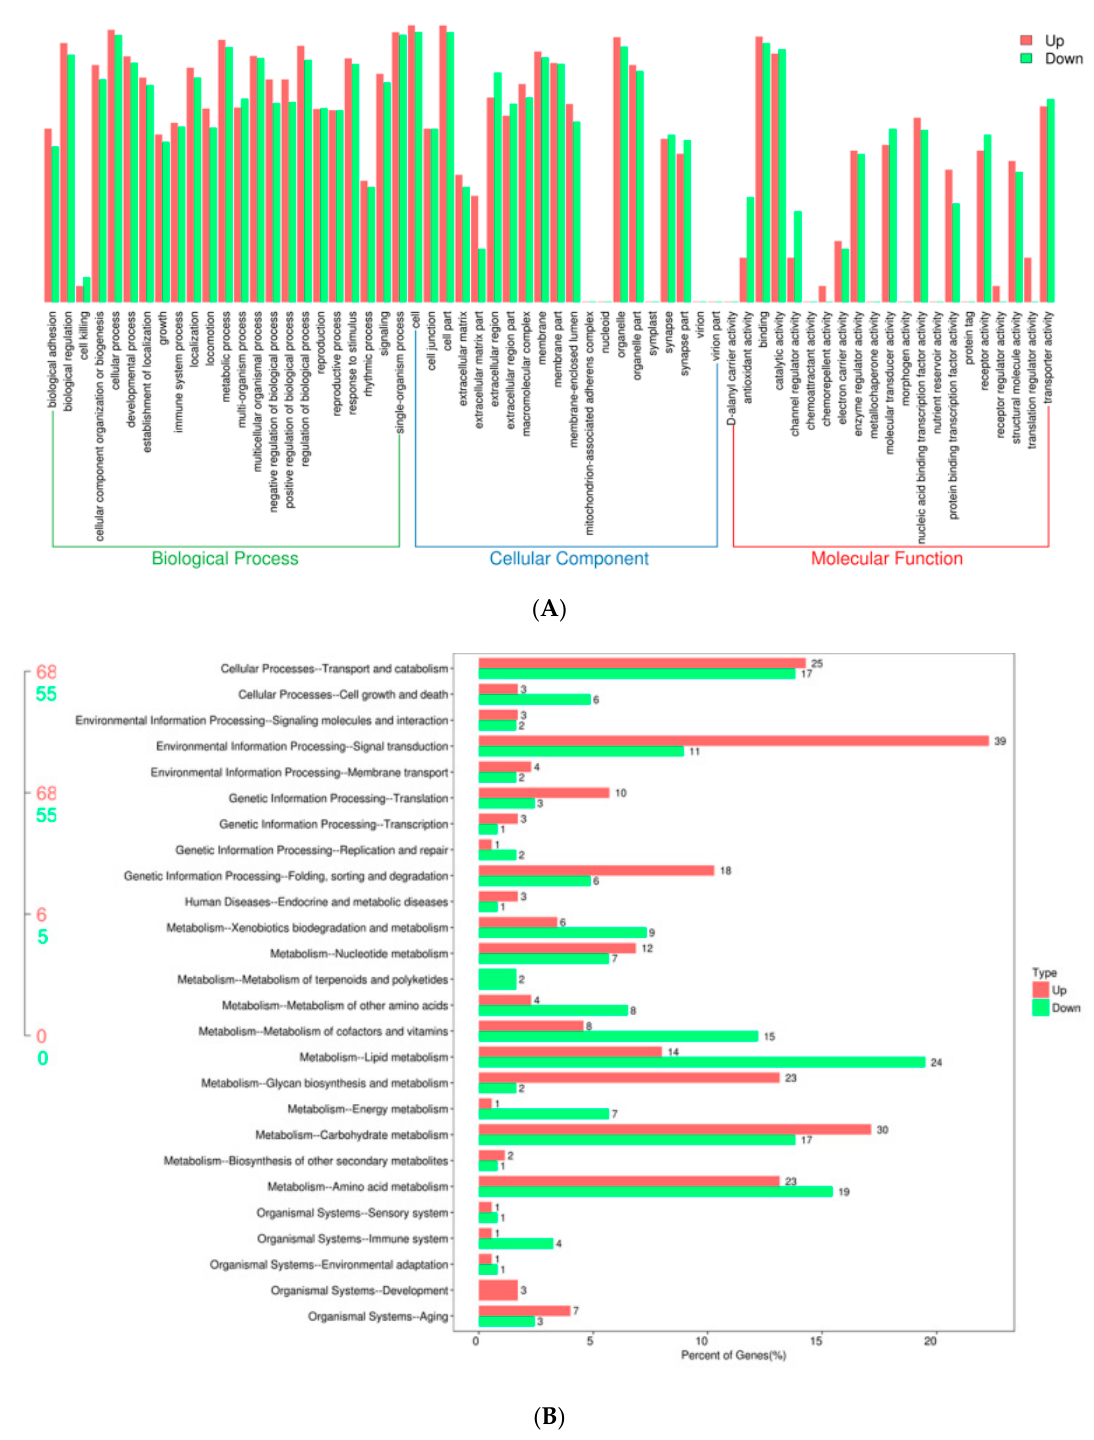
Figure 1. Enrichment analysis of differentially expressed genes (DEGs) following HCl treatment. ( A ) Annotation of DEGs with GO enrichment. Gene numbers and percentages are listed for each category. ( B ) Kyoto Encyclopaedia of Genes and Genomes (KEGG) pathway enrichment of DEGs. The red and green bars represent upregulated and downregulated genes, respectively, and the number represents the percentage of genes.